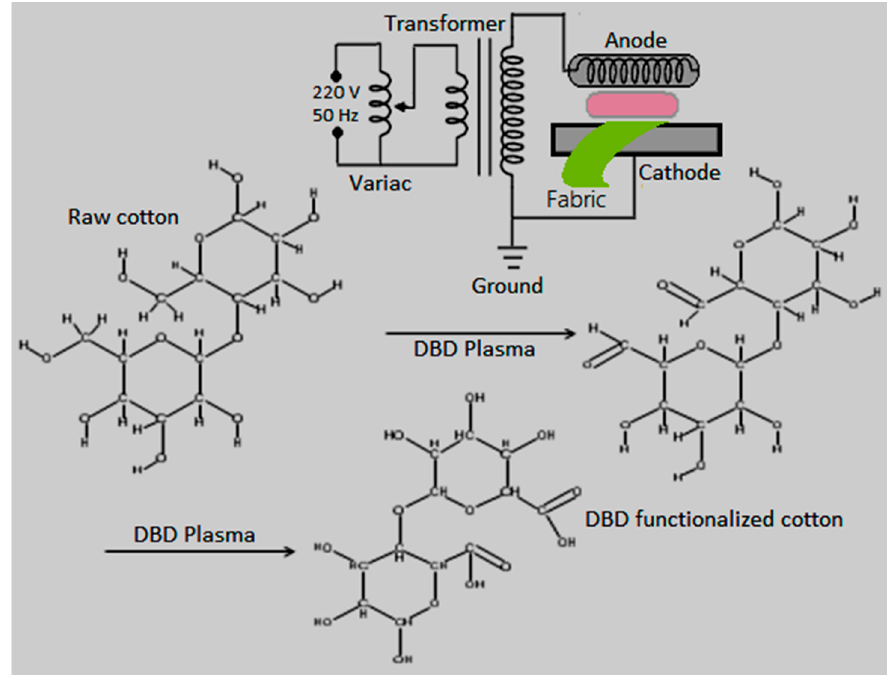
Figure 1. Illustration of the nonthermal DBD system for the activation of cotton and possible chemistry involved in surface functionalization.